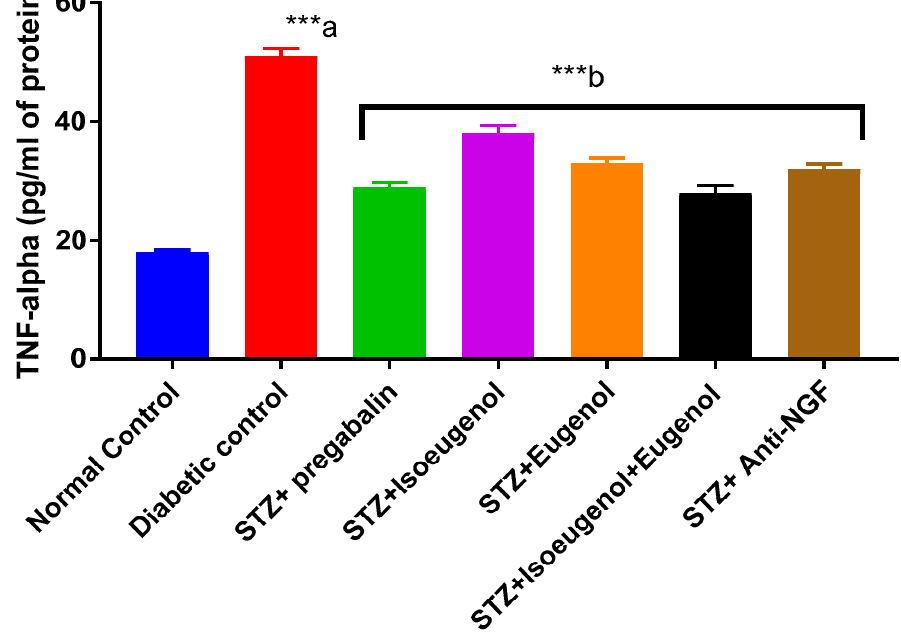
Figure 5. Effect of isoeugenol, eugenol, and their combination on TNF- α levels. A p < value of 0.05 was considered statistically significant. Significance is represented as *** p < 0.001; a—normal control versus diabetic control, b—diabetic control versus treatment groups. TNF — tumor necrosis factor.